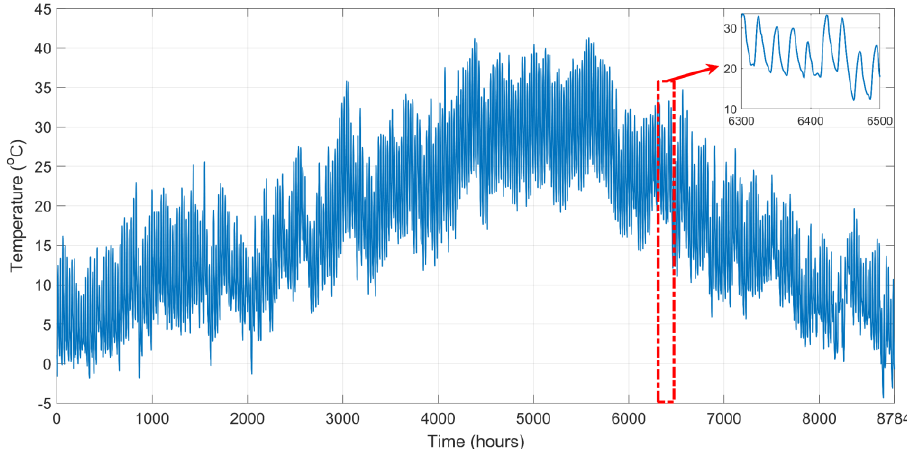
Figure 6. The annual ambient temperature of the studied site.